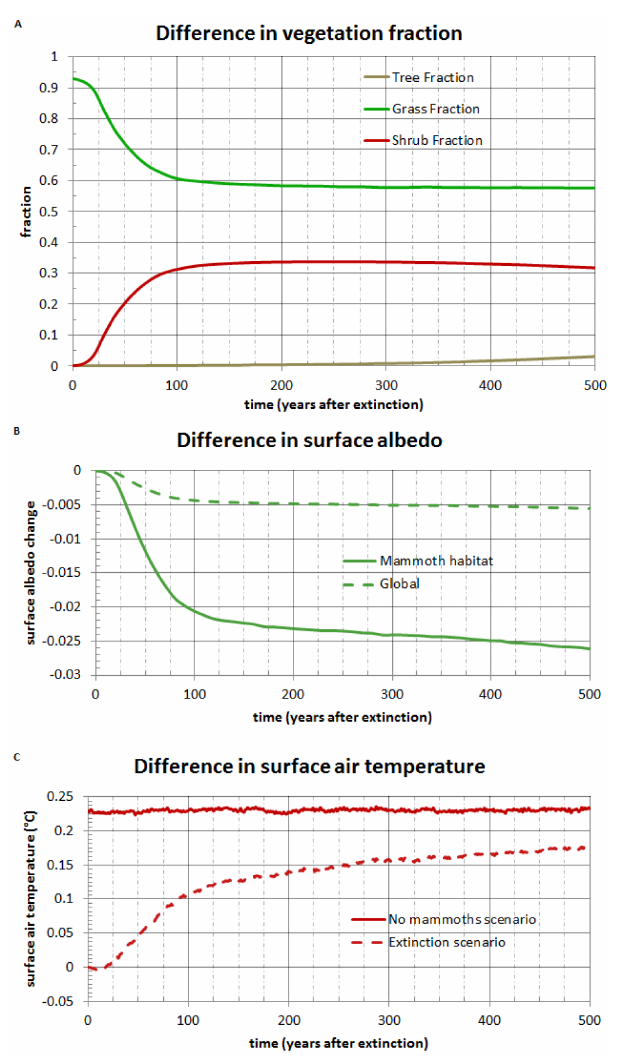
Fig. 1. Results of the MIS (maximum impact scenario – all trees north of 30 ◦ N removed by the mammoths, so that their extinction results in the largest possible reforestation), plotted as time series of the first 500yr after extinction. To produce each curve we subtract the control run (CTL – model tuned with the mammoths’ impact on vegetation, but the mammoths do not go extinct) from the extinction run (EXT – same as CTL, but the mammoths go extinct at year 0 of the simulation); the only exception is the solid line in (c) , in which CTL is subtracted from the background simulation (no mammoths). The panels display differences in (a) the vegetation fraction for ev- ery main vegetation type, averaged over the mammoth area; (b) the surface albedo, averaged over the globe (dashed line) and over the mammoth area (solid line); and (c) the globally-averaged tempera- ture for the “extinction” run (dashed line) and the “no mammoths” background simulation (solid line).